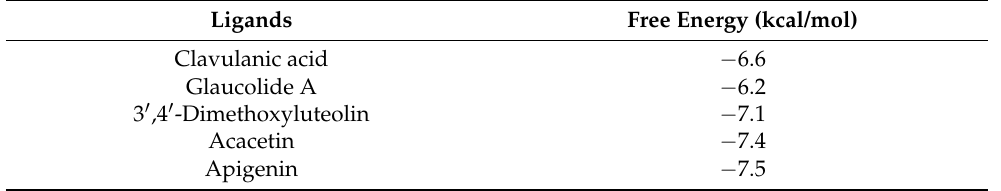
Figure 5. Main molecular interactions between compounds and class β -lactamase catalytic site of S. aureus . ( A ) Clavulanic acid. ( B ) Glaucolide A. ( C ) 3 ′ ,4 ′ -Dimethoxyluteolin. ( D ) Acacetin. ( E ) Apigenin. Dark green: hydrogen bonding; Light green: Van der Waals; Light pink: alkyl or π -alkyl; Dark pink: π -stacking; Light blue: permanent-dipole. Dashed lines: aromatic ring. Table 4. Free energy values of